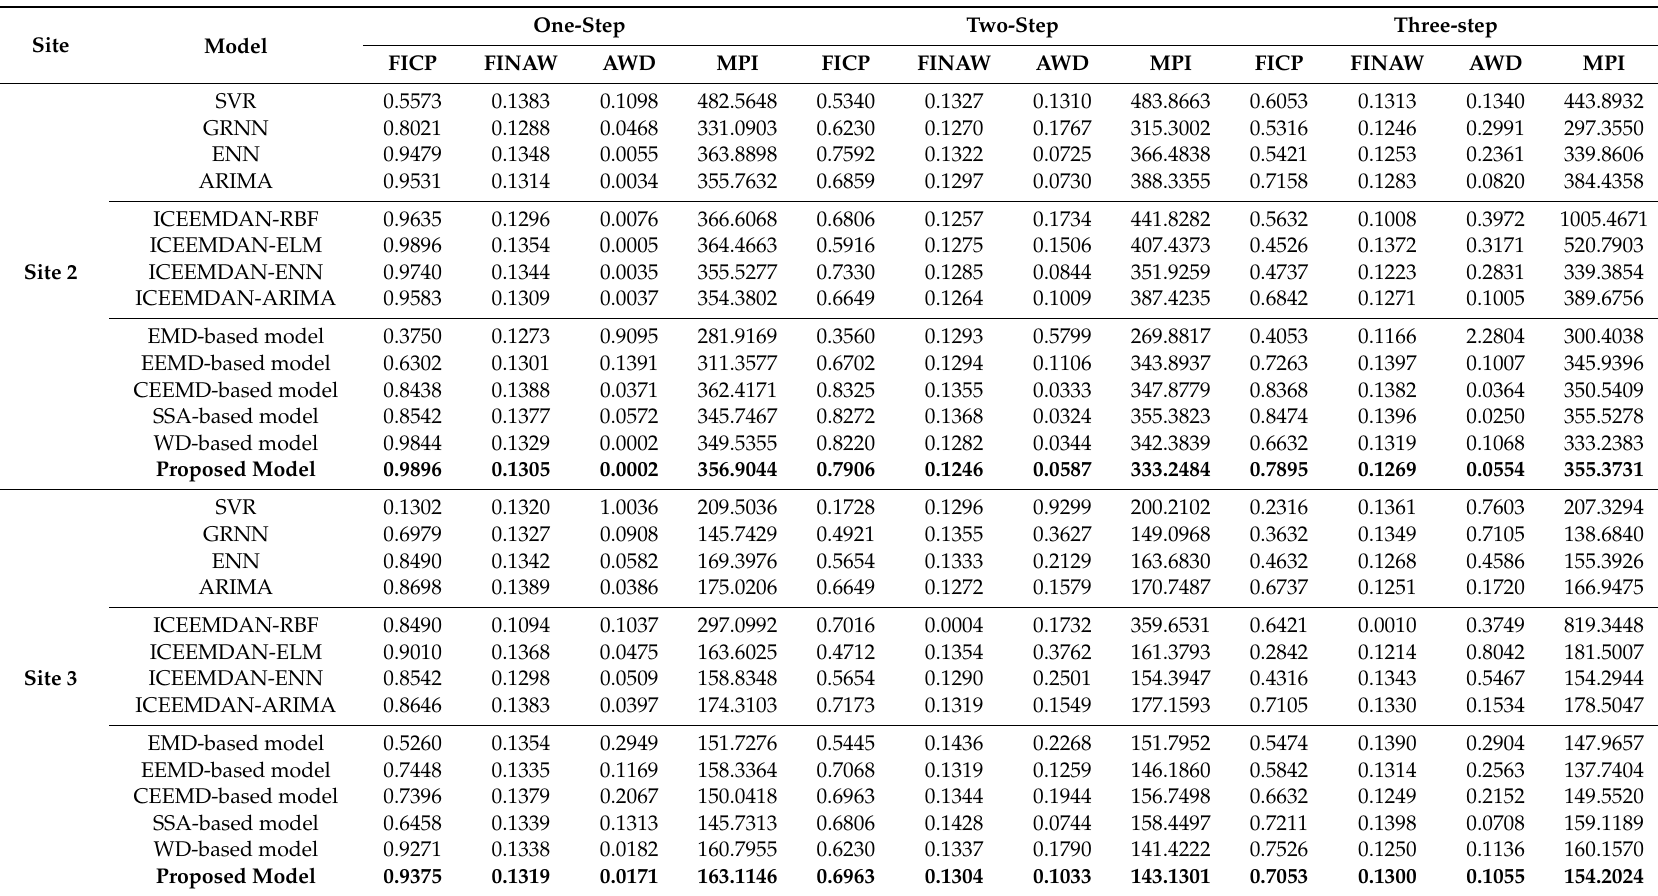
Table 7. The designed model comparing with all other models for site 2 and site